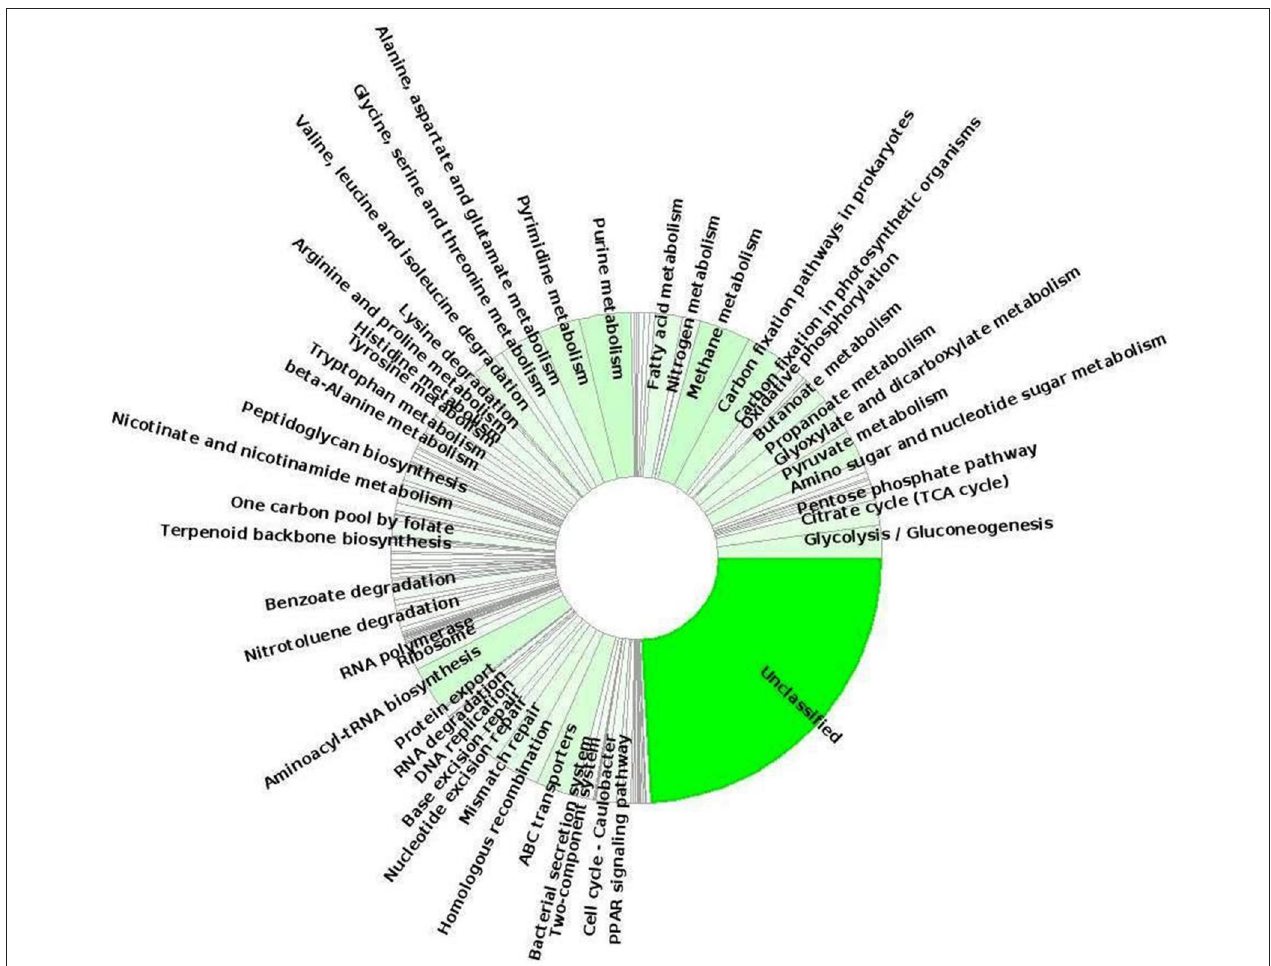
FIGURE 7 | Relative distribution of predicted protein-coding genes sequences that matched various KEGG pathways and were phylogenetically affiliated to Candidate phylum Acetothermia within the TB-3 metagenome sequence obtained using MEGAN5